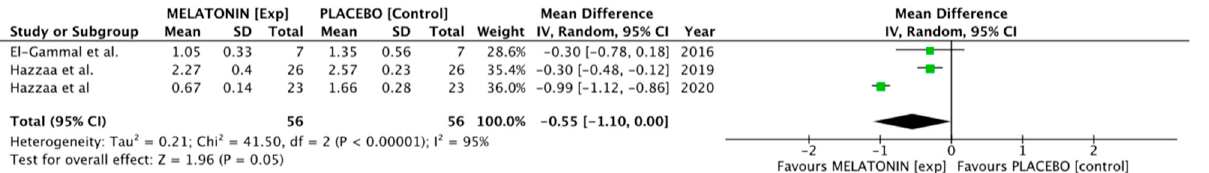
Figure 4. Forest plot for the meta-analysis of the human clinical trials assessing crestal bone loss 6 months after placement, taking the mean difference as the effect size index, weighting by inverse variance and assuming a random effects model. CI = Confidence Interval.